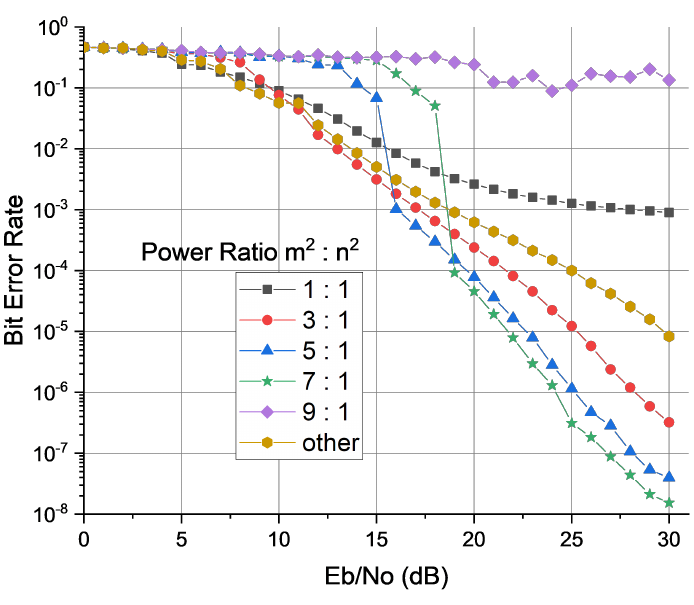
Figure 16. Bit error rate performance of transmitted